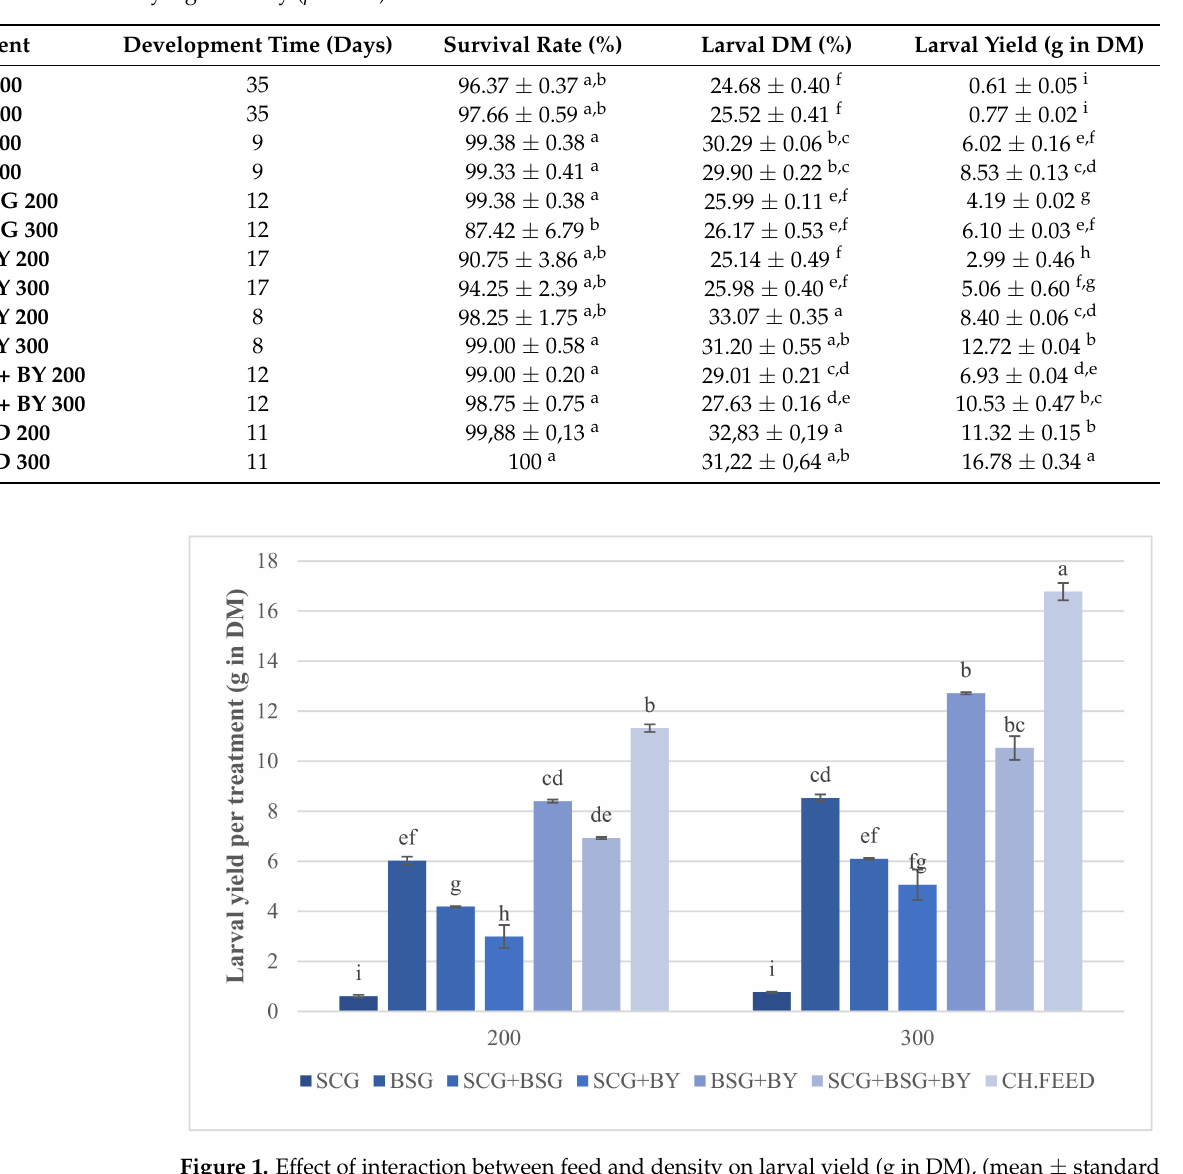
Figure 1. Effect of interaction between feed and density on larval yield (g in DM), (mean ± standard error, n = 4). Mean values followed by the same letter do not differ significantly ( p <